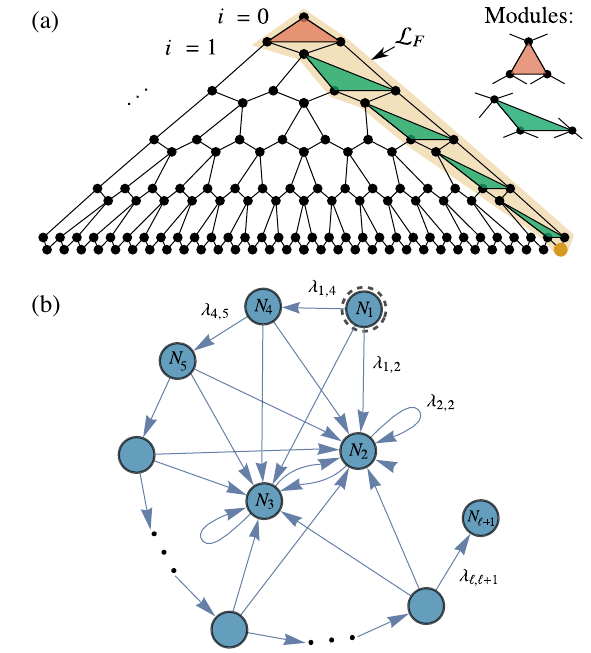
FIG. 4. GRIM for the case when W is in the edge of l th layer of the QCNN. (a) The forward light cone can be covered with ( l − 1 ) edge modules M E and a single center module M C . Here, W is indicated with a larger colored circle. (b) Graph obtained from the GRIM by integrating all modules M E in ar L for the F case in (a). Graph G obtained via GRIM. Here the edge w coefficients λ are real and positive numbers such that i;j ∈ ð 0 ; 1 Þ . Moreover, for this case the number of nodes is λ i;j ( l þ 1 ), and the structure of the graph is such that one can easily obtain the graph for any value of l